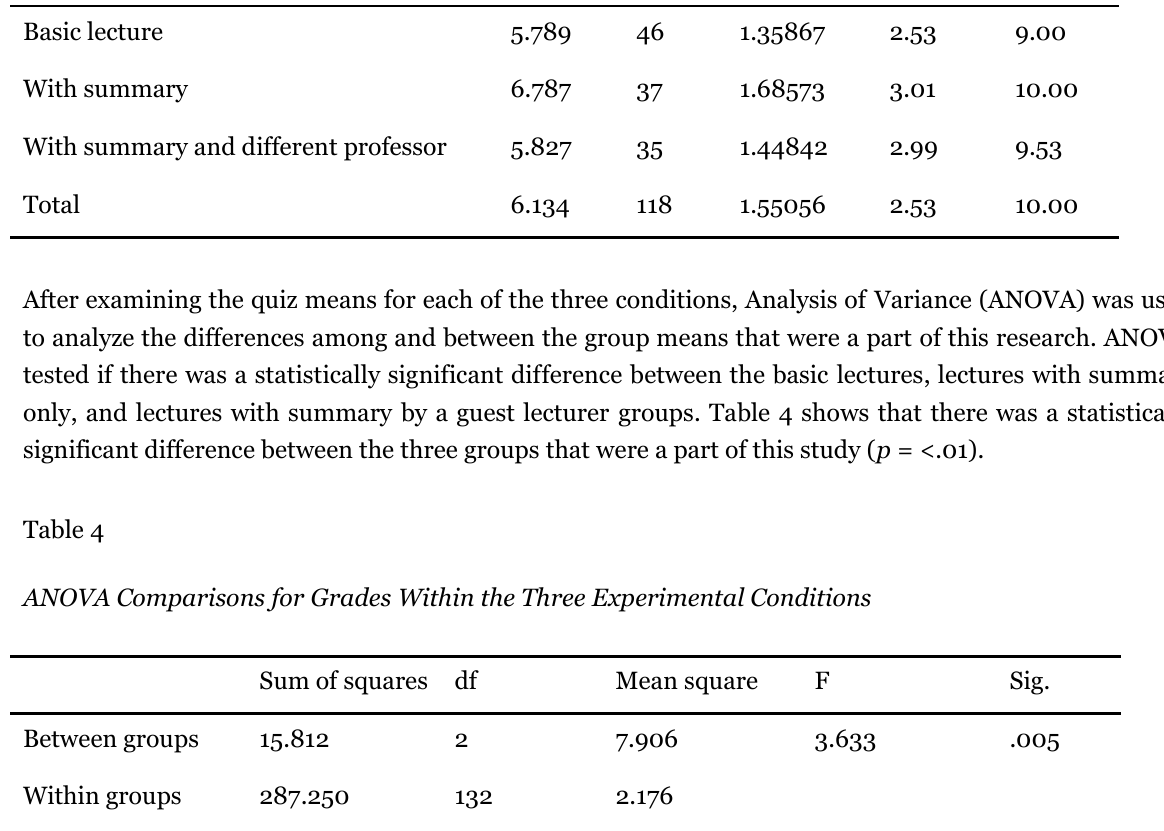
ANOVA Comparisons for Grades Within the Three Experimental Conditions Sum of squares df Mean square F Sig. Between groups 15.812 2 7.906 3.633 .005 Within groups 287.250 132 2.176 Total 303.063